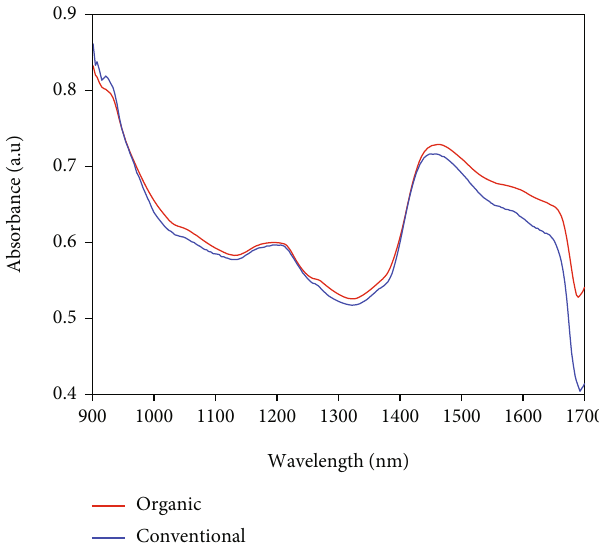
Figure 2: Mean spectra pro fi le of organic and conventional cocoa bean